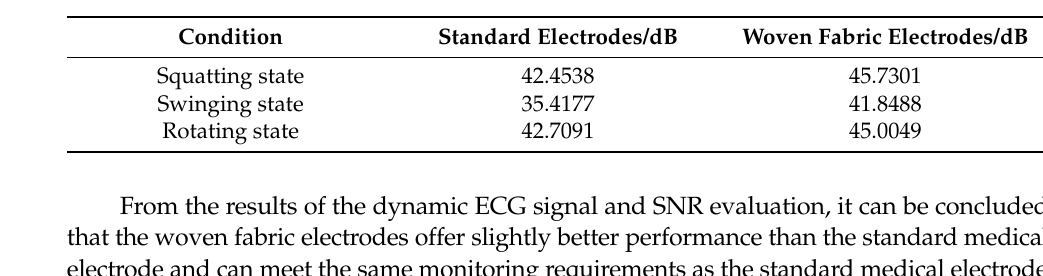
Figure 9. ( a ) Process of measuring ECG signal in rotating state. ( b ) ECG signal of woven fabric electrodes and standard medical electrodes in rotating state.